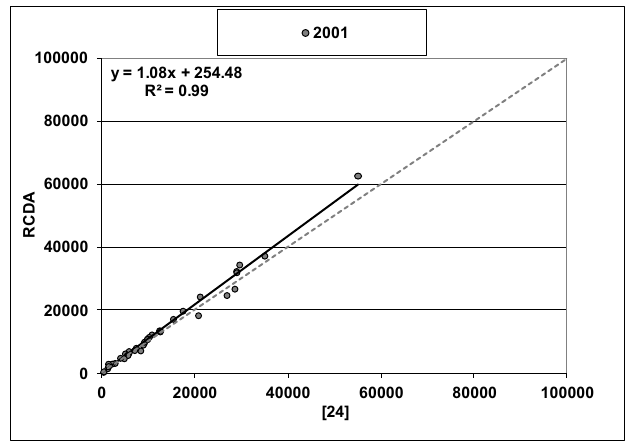
Figure 4. Scatterplot diagram and regression analysis, of soybean area estimates, between RCDA and the reference map [3].